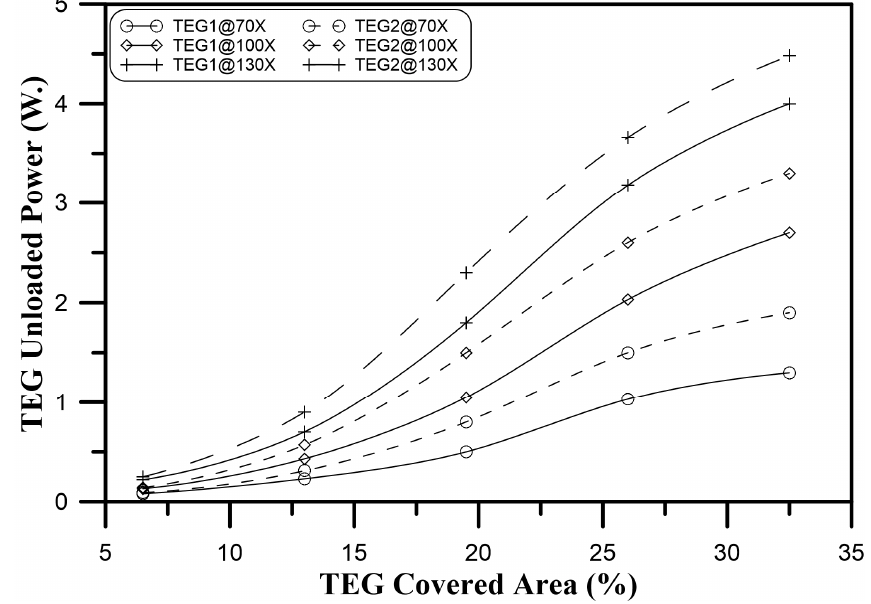
Figure 5. TEGs’ unloaded output power increased as a function of increasing the covered area of its surface.